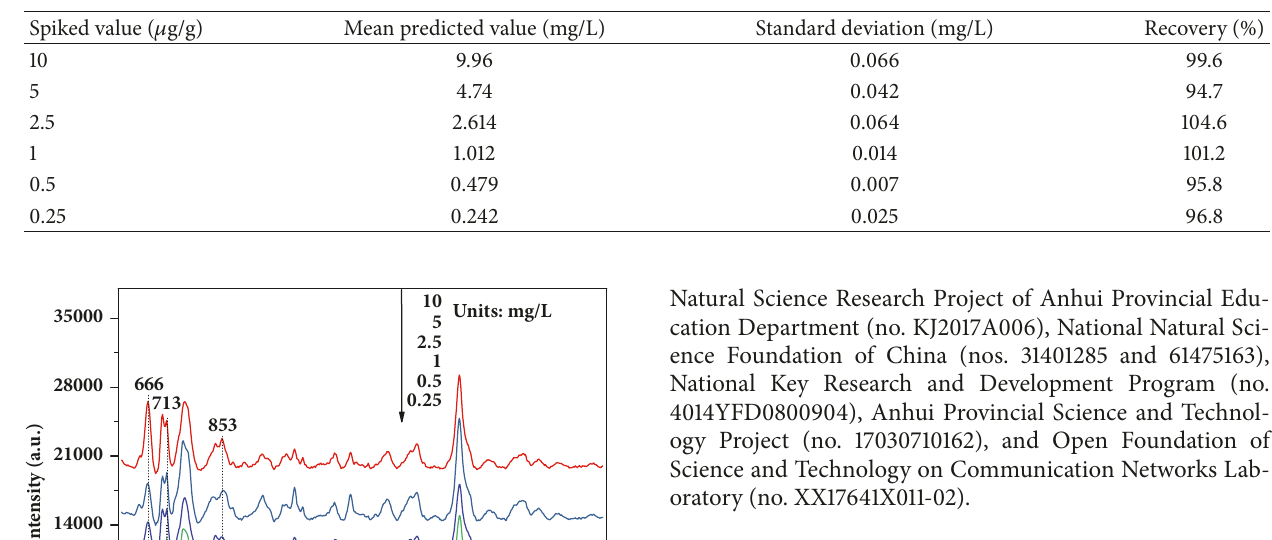
Table 3: Predicted results of chlormequat chloride in wheat using SERS, SVR, and KPCA.